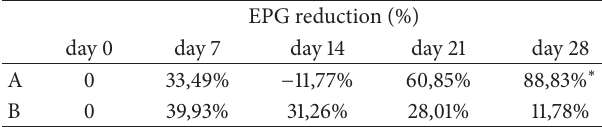
Table1:EPGreduction(%)ingroupsofdogsnaturallyinfectedwith Ancylostomidae: treated with probiotics (A) and untreated (B).